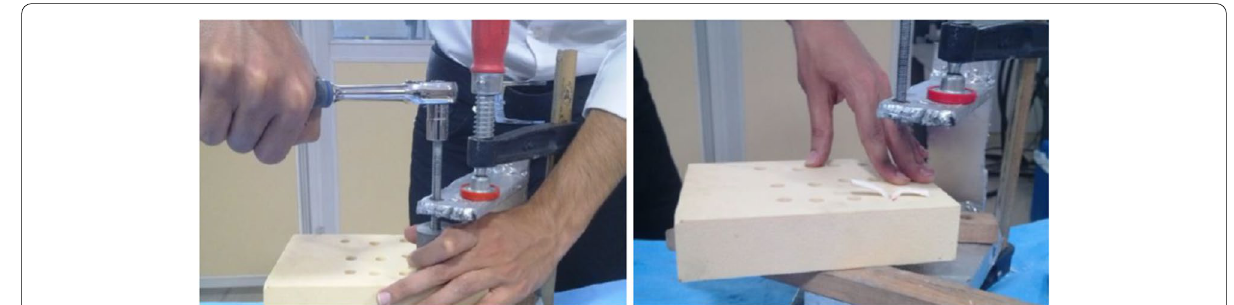
Fig. 5 Insertion process of core bone into the tunnel; a guide cylinder supported the core bone against buckling or possible fracture